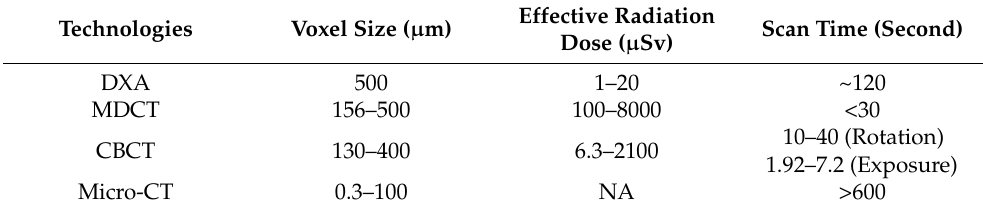
Table 1. Descriptive summary of X-ray based technologies [11].